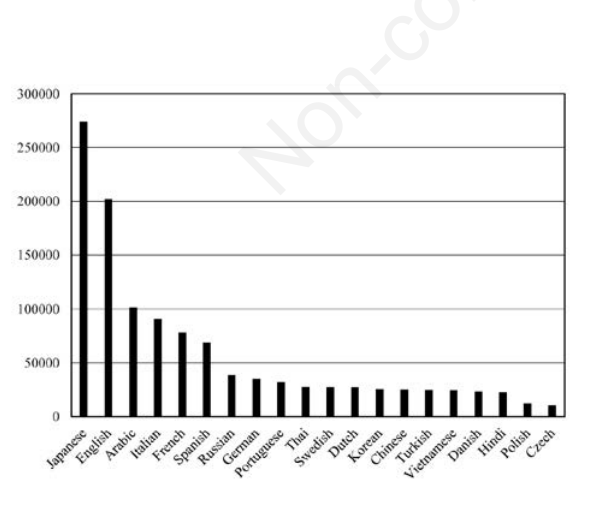
Figure 2. Number of visitors to each language version. The Japanese version of the site was the most popular, accounting for 23.8% of visitors, followed by the English version (17.6%), the Arabic version (8.8%), the Italian version (7.9%), the French ver- sion (6.8%), and the Russian version (3.3%).